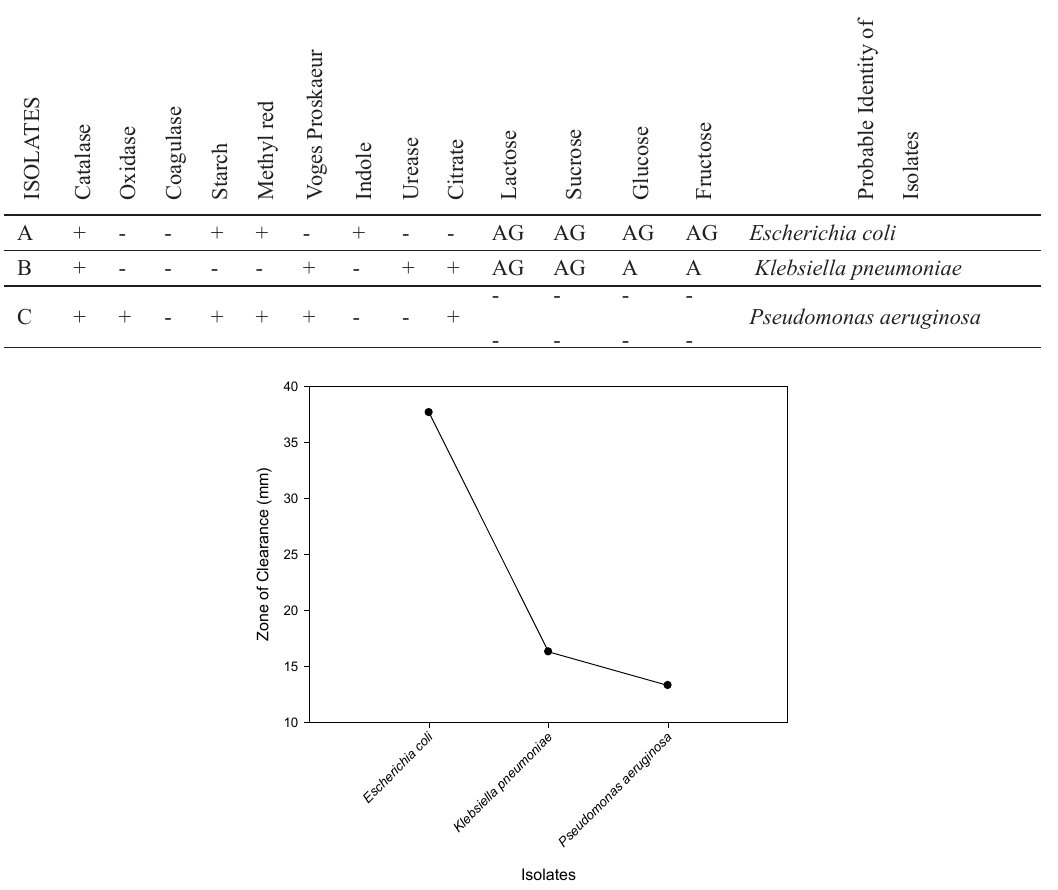
Figure 2: Antibacterial activity of Honey ( Apis mellifera ) on Table 3: Antibiotic Susceptibility pattern of test isolates.